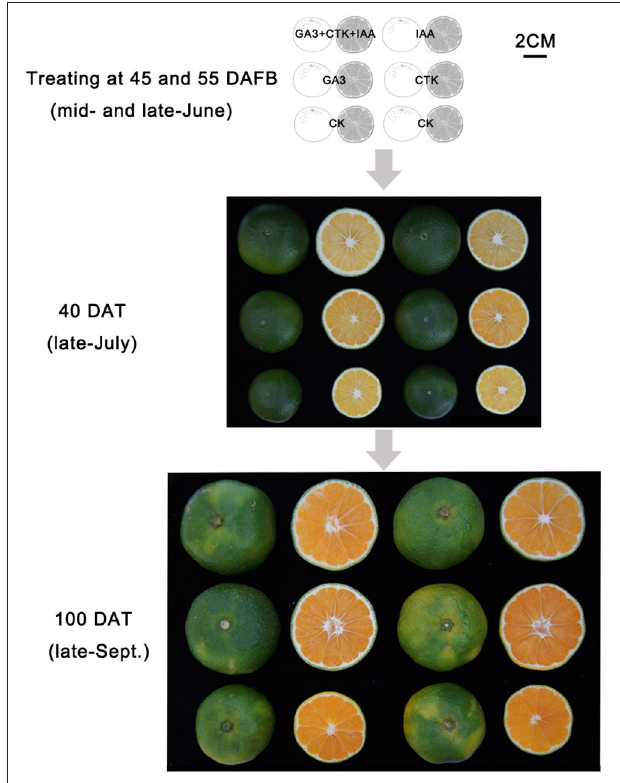
FIGURE 8 | Fruit development after hormone treatment.